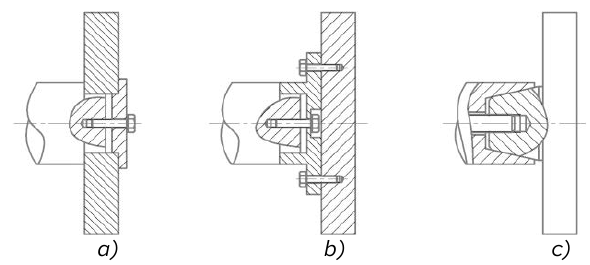
Fig. 3. Fitting o ptions f or a n u ltra-fast g rinding w heel: a) nozzle mount; b) striking mount; c) end mount. The cal culation o f t ensile s tresses i s b ased o n